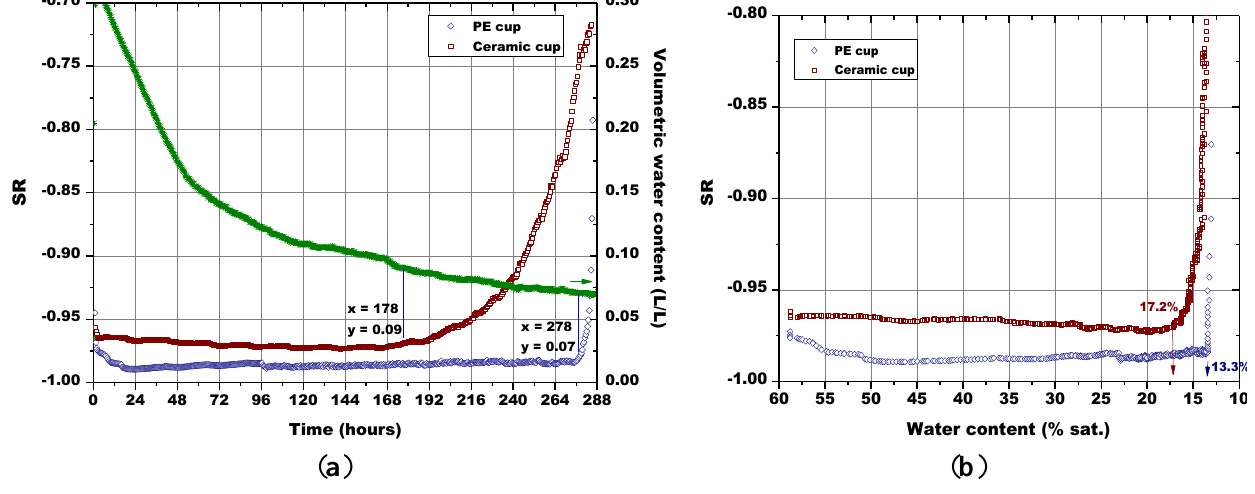
Figure 13. ( a ) Evolution of: the sensors response and of soil water content in function of time; ( b ) The sensors response in function of soil water content; influence of the PE and of the ceramic porous cup (soil temperature = 50.5 °C ± 0.8 °C, soil density about 1.30 g/cm 3 ).